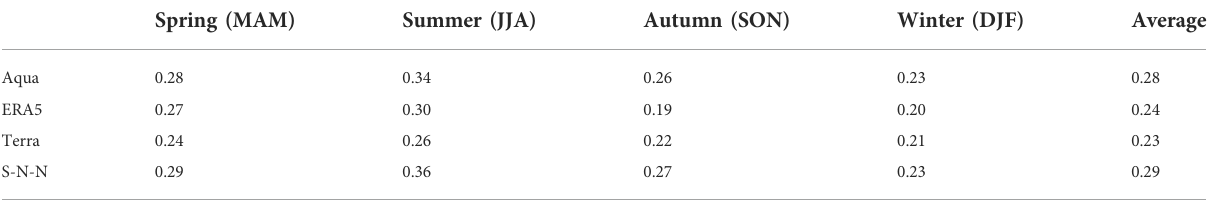
TABLE 2 The multi-year mean mass of aerial cryosphere over the TP derived from three satellite products and ERA reanalysis from 2013 to 2020 (Unit: